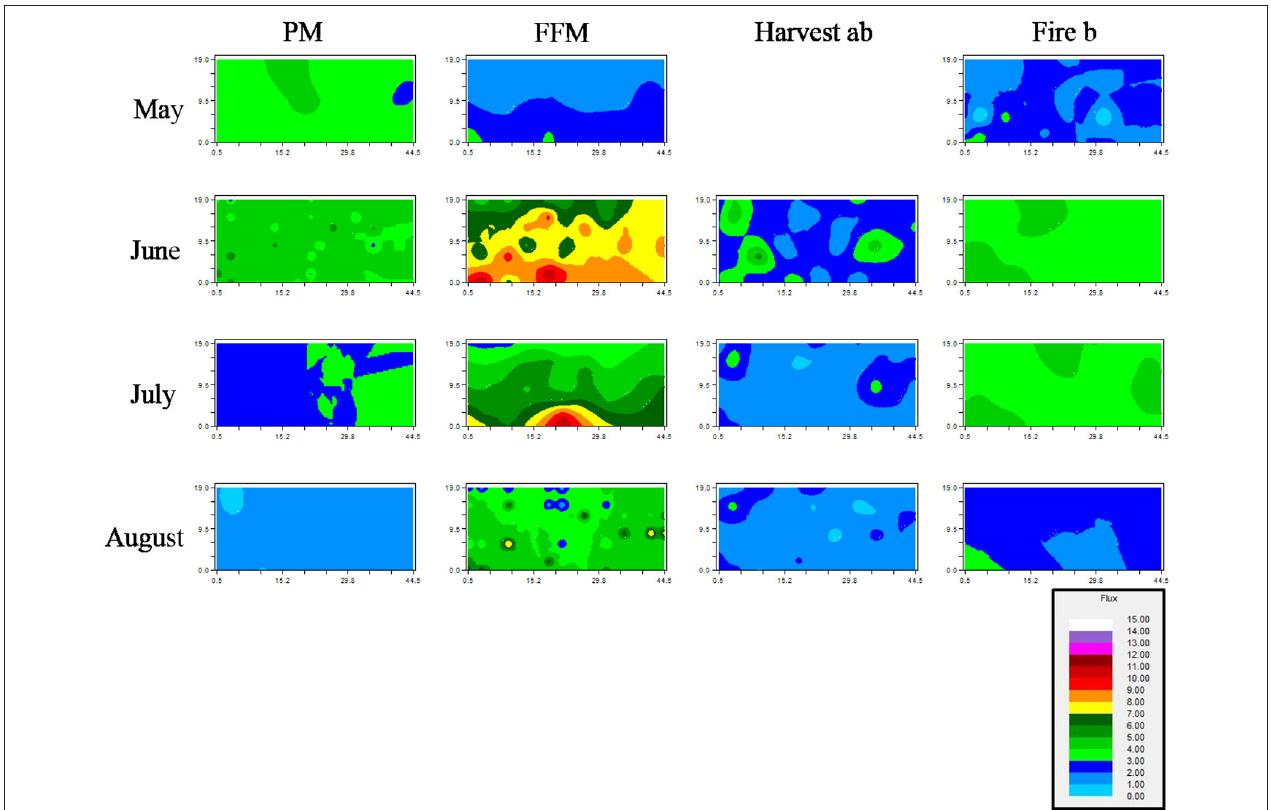
FIGURE 6 | Kriging maps of soil respiration based on fitted variogram models. Modeled spatial soil respiration is expressed in µ mol CO 2 m − 2 s − 1 . Peat mineral-mix (PM), forest floor mineral-mix (FFM), Harvest ab by timber harvesting disturbed a/b ecosite, Fire b a by forest fire disturbed type b